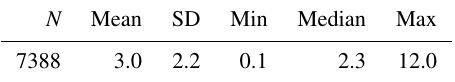
Table 2. Climatological statistics of clear-sky IWV levels above the Zugspitze derived from N multi-annual solar FTIR measurements shown in Fig. 3. Numbers are given in units of